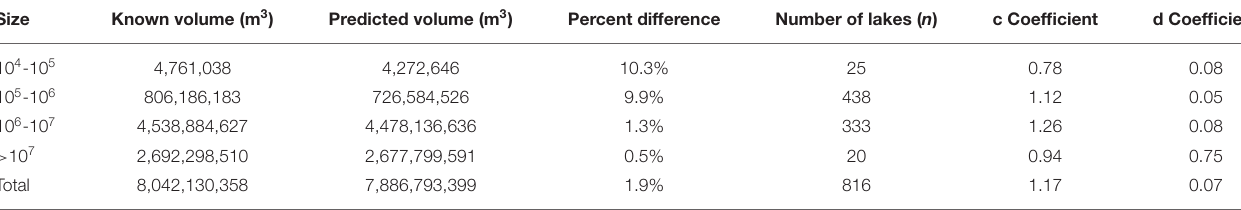
TABLE 4 | Total predicted volume by each lake size in the study area based on Heathcote et al. (2015) model.